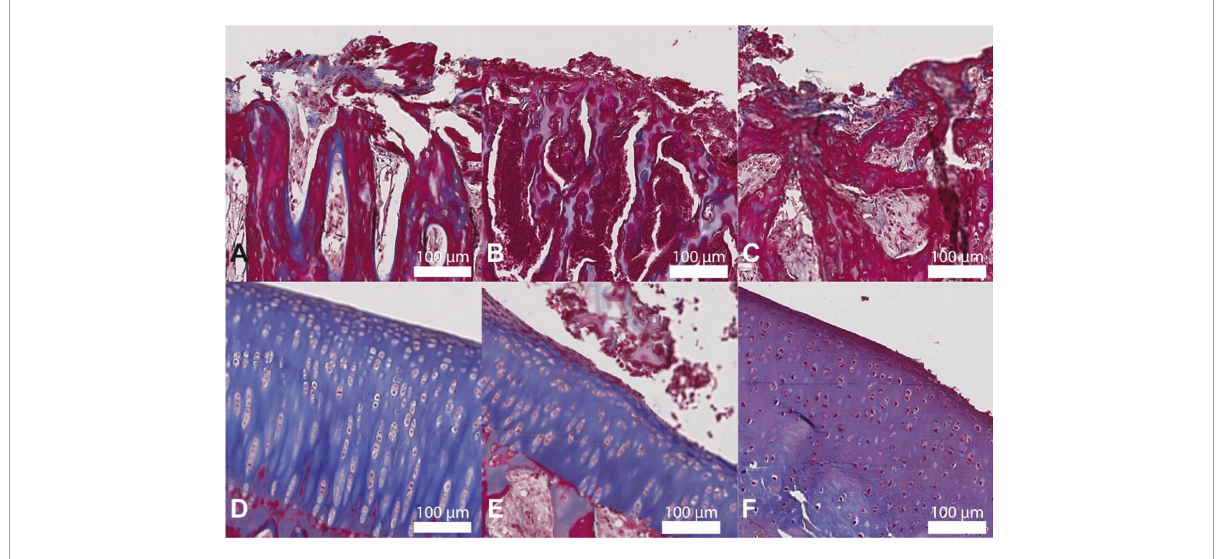
FIGURE7 Histological images of the bone-implant interface and articular cartilage stained with Masson’s blue trichrome of groups A (panels A,D , respectively), B (B,E) , and C (C,F) . The infiltrates observed in the bone trabeculae in panel B are absent in panel A and are greatly reduced in panel C . The cartilage surfaces in panels D–F are similar. A total of 200 × magnification, scale bar 100 µ